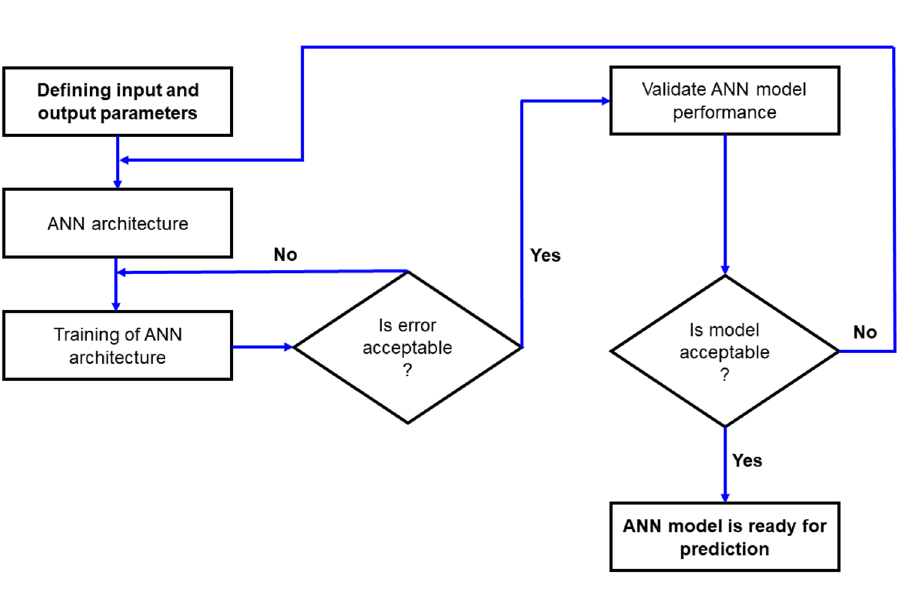
Figure 9. ANN prediction